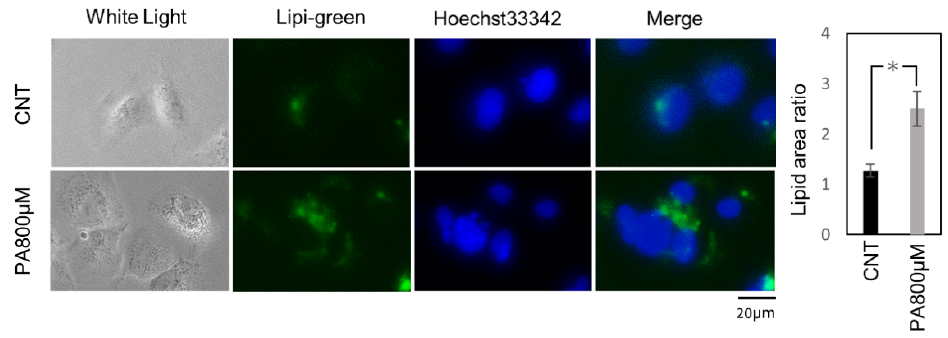
Figure 1. Palmitate-induced steatosis. Representative fluorescence images of Lipi-green staining on Huh-7 cells treated with 1% BSA for the controls or 800 μ M of palmitic acid for the treatment group. The results were expressed as the ratio compared with the control. The quantification is based on ten randomly captured fields in each group. Bars indicate average ± SEM. * p < 0.05. CNT, control; PA, palmitic acid.